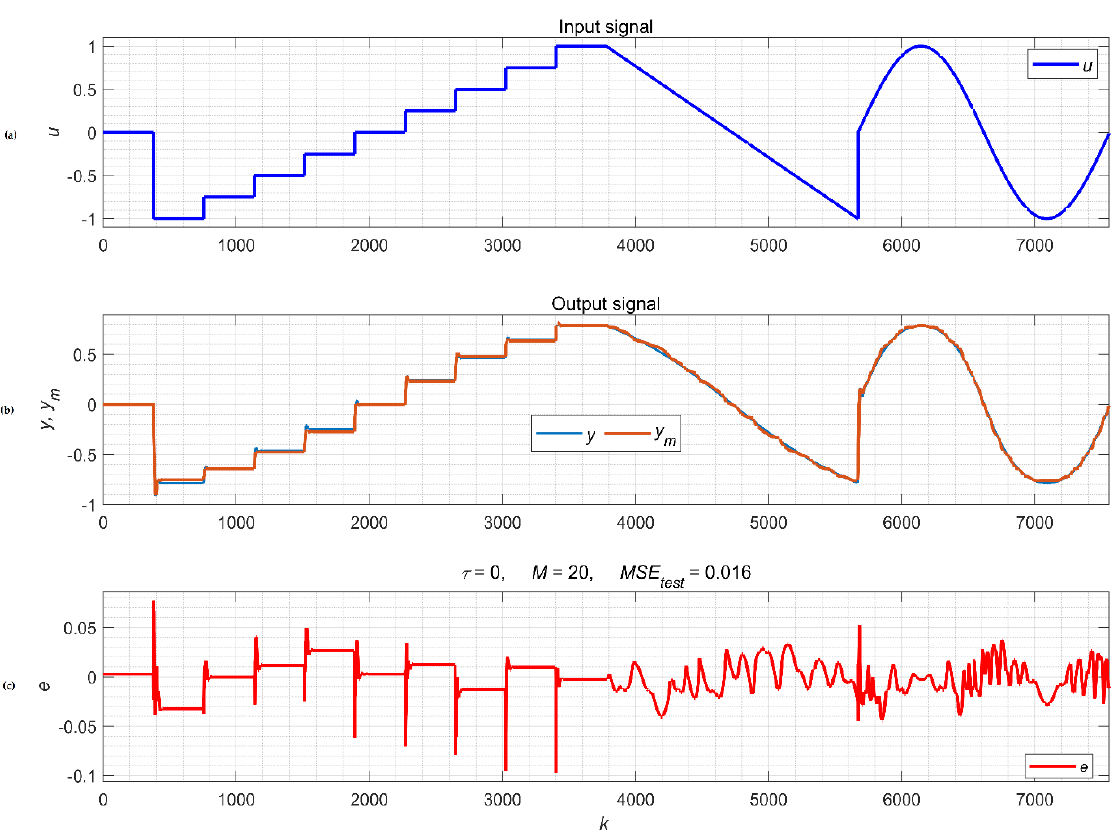
Figure 9. Comparison between desired outputs y and predicted outputs y m for the Hammerstein nonlinear dynamic test process obtained in the testing session: ( a ) testing input signal; ( b ) model output signal y m and the output y of the process; ( c ) model error e .